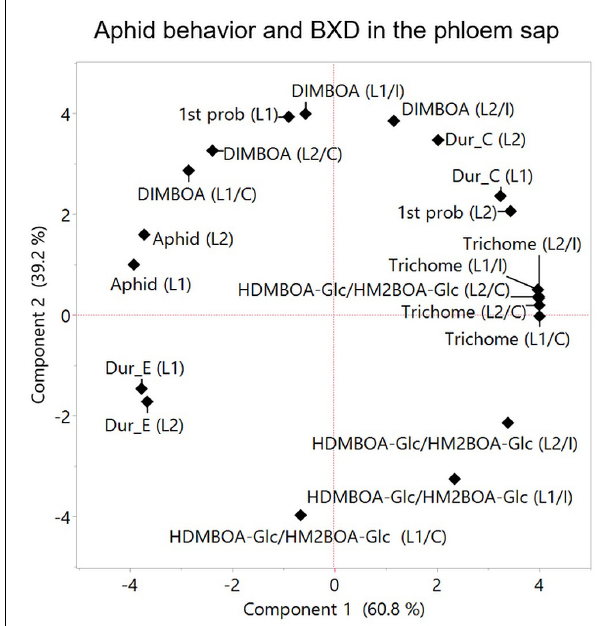
FIGURE 9 | Principal component analysis plot for parameters measured at the phloem level. Aphid feeding behavior was analyzed using the EPG technique only for two leaves (leaf-1 [L1] and leaf-2 [L2], and results were integrated to aphid progeny, trichome density, and BXDs (DIMBOA and HDMBOA-Glc/HM2BOA-Glc) detected in the phloem sap. The data for the trichomes and BXDs are the constitutive levels [C] and aphid-induced [I]. Average values were normalized to log2 transformation for the projection of PCA. The accessions that were tested in this analysis are TD-805, TD-2056, and